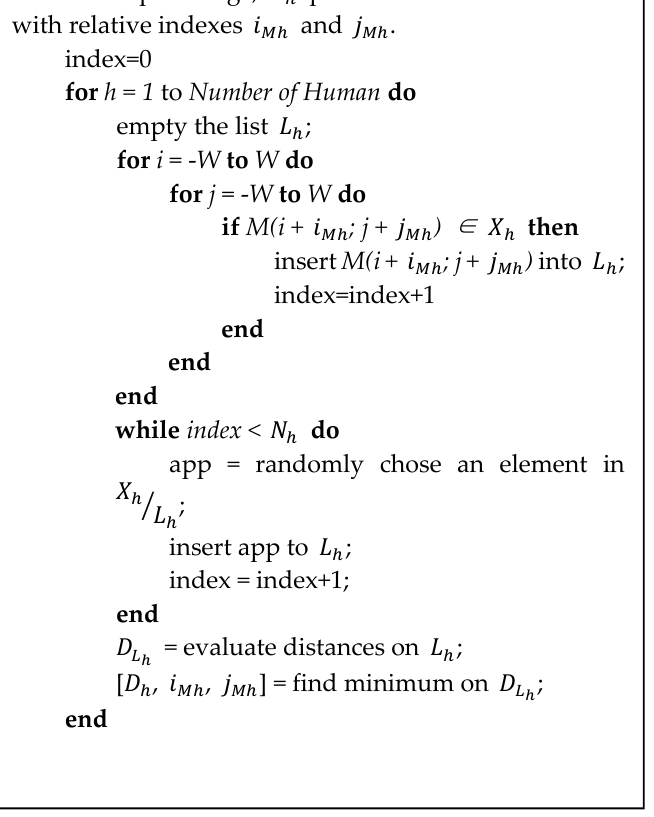
Figure 4. Pseudo ‐ code of the Distance Probability Estimation (DPE) algorithm. Figure 4. Pseudo-code of the Distance Probability Estimation (DPE)